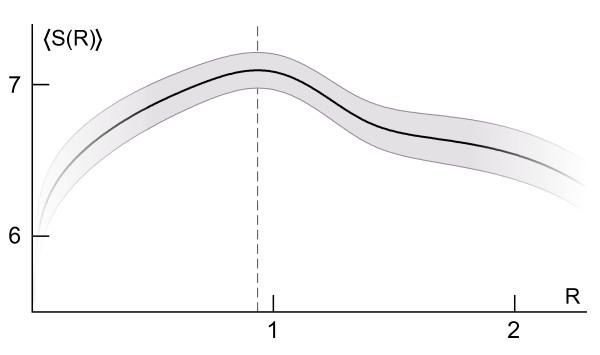
Entropy of expected reduced central distances in globular proteins. The entropy, S(R), of p¯(R;τ) was averaged over all proteins from the learning set and is expressed in bits (black line; gray band - standard deviation of the mean entropy; dashed line - location of the maximum). "Twilight zones" mark regions where the entropy was calculated using tails of distributions.